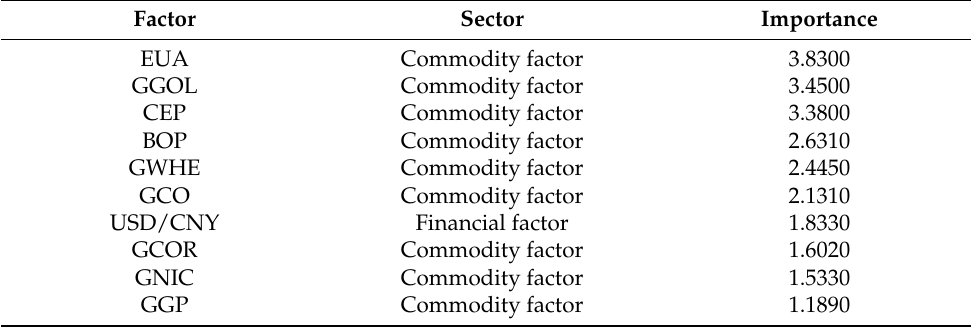
Table 7. Description of the most important selected factors, using ElasticNet. Factor Sector